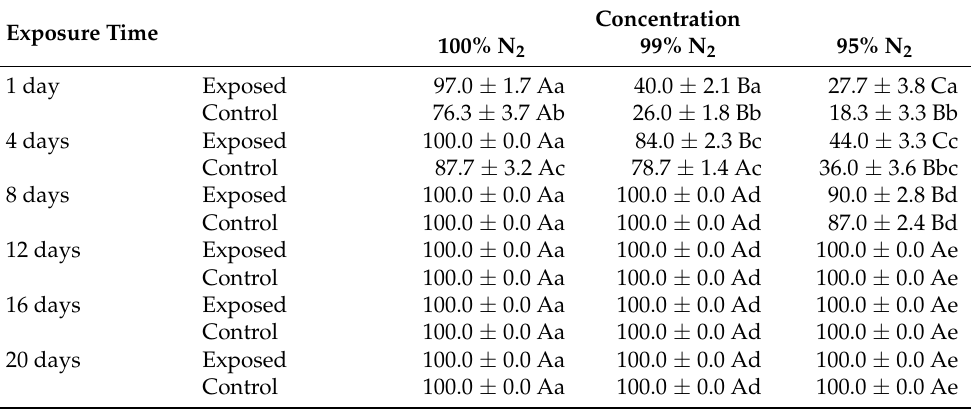
Table 4. Laboratory efficacy (% of mean adult mortality; Av. % ± SE) of six exposure times (ranging from 1 to 20 days) and three concentrations (ranging from 95% to 100% N2) nitrogen-based controlled atmospheres on the exposed adults of adzuki bean weevil ( Callosobruchus chinensis ). (Different letters indicate statistically significant differences between variables).